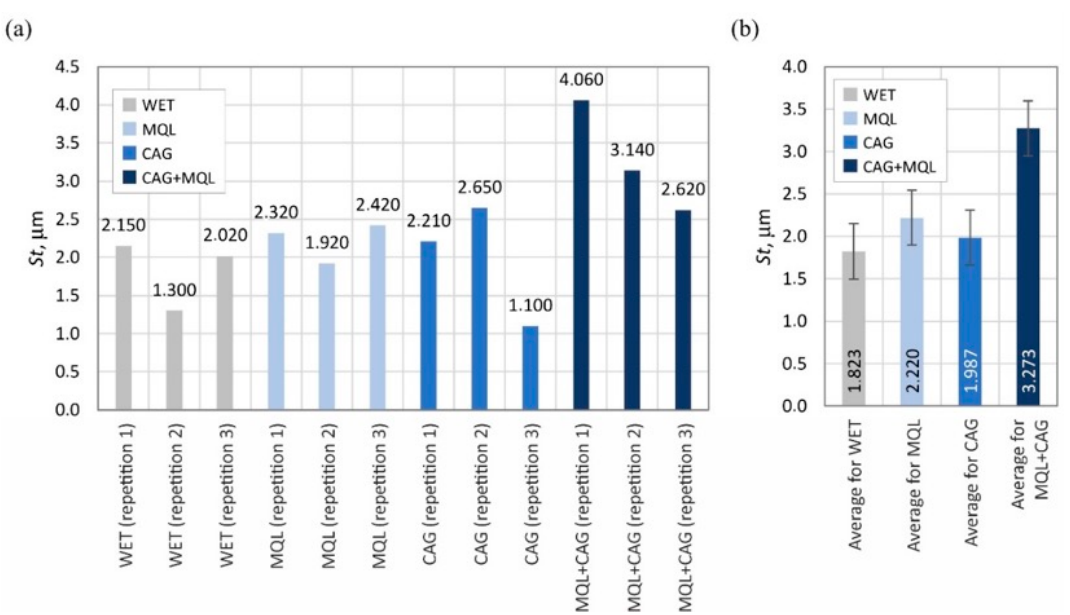
Figure 8. Chart of changes in the total height of the surface St : ( a ) results for the twelve blades selected for the surface texture measurements; ( b ) mean values of the parameters divided by cooling and lubrication methods of the grinding zone used during the shaping of the blades (error bars represent the standard error equal to the standard deviation σ divided by the square root of the total number of samples).